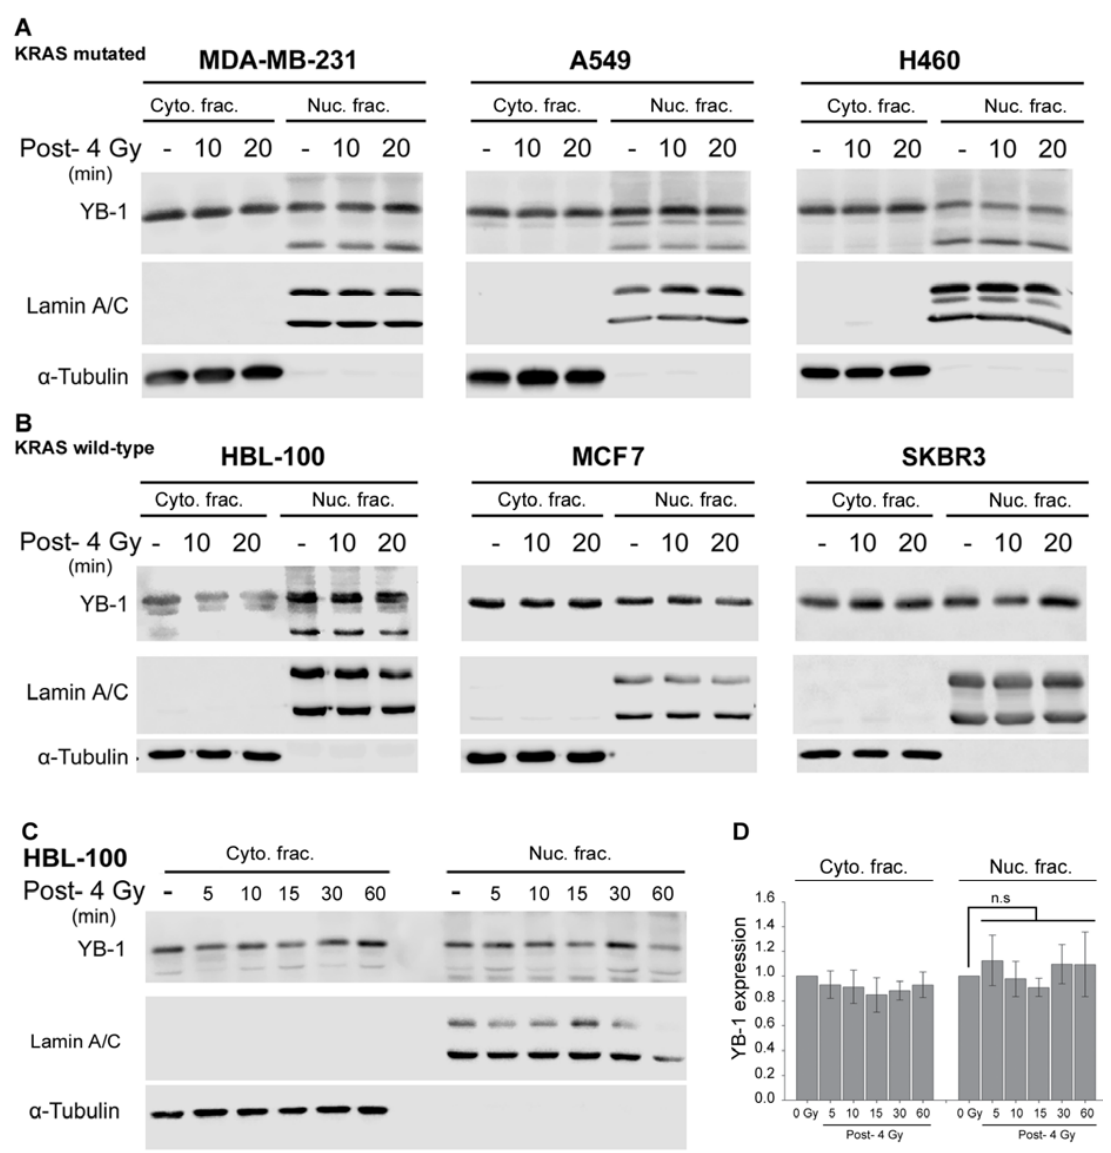
Figure 1. Y-box binding protein-1 (YB-1) is not translocated to the nucleus after irradiation. ( A ) A KRASmut breast cancer cell line (MDA-MB-231), non-small cell lung cancer cell lines (A549, H460), and ( B,C ) KRASwt breast cancer cell lines (HBL-100, MCF7, SKBR3) were irradiated (4 Gy). Cytoplasmic and nuclear protein fractions were isolated at the indicated time points after irradiation and subjected to SDS-PAGE. YB-1 was detected by Western blotting. α -Tubulin and lamin A/C were used as cytoplasmic and nuclear markers, respectively. ( D ) Histogram representing the densitometry data for the mean expression of YB-1 ± S.E.M. within one hour after ionizing radiation (IR) from four independent experiments in HBL-100 cells.